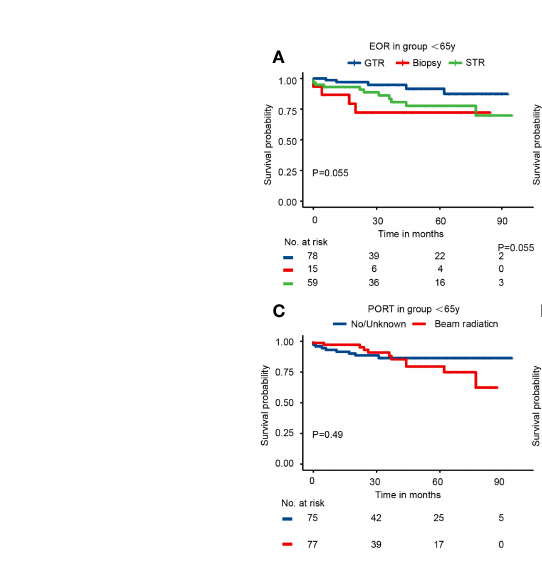
FIGURE 3 | The Kaplan – Meier curves by EOR and PORT in different age groups. (A) EOR in group <65 years. (B) EOR in group ≥ 65 years. (C) PORT in group <65 years. (D) PORT in group ≥ 65